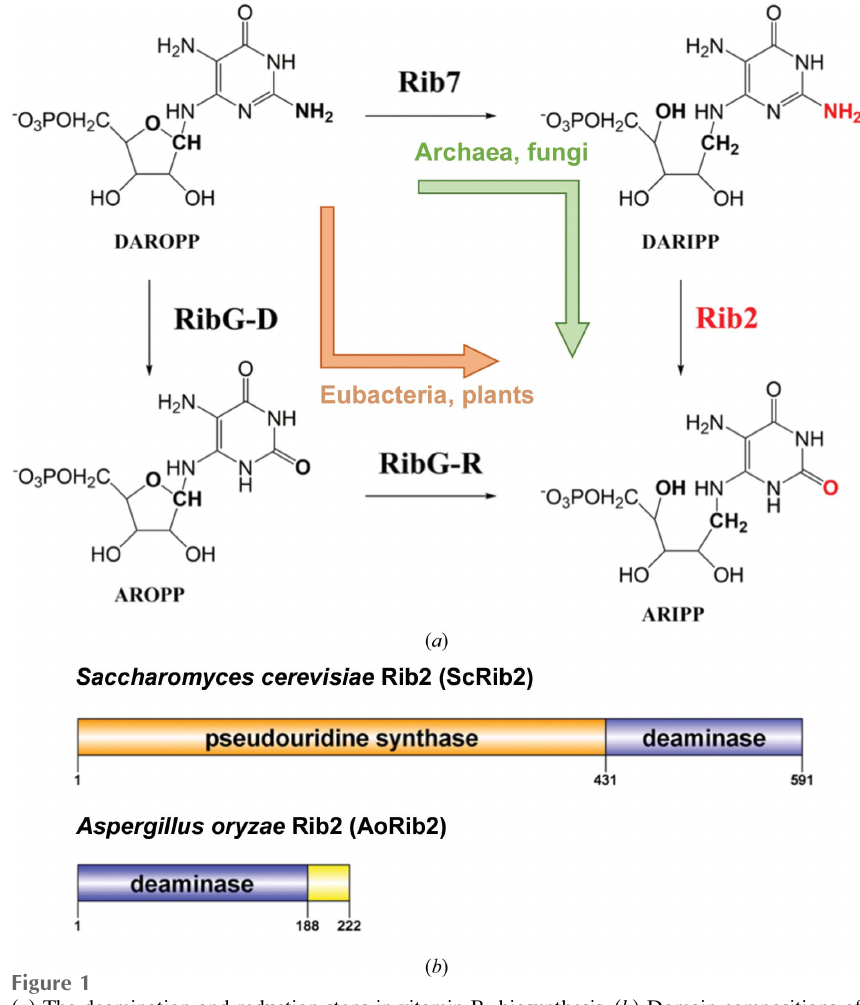
Figure 1 ( a ) The deamination and reduction steps in vitamin B 2 biosynthesis. ( b ) Domain compositions of ScRib2 and AoRib2. The pseudouridine synthase domain is shown in orange and the deaminase domains are shown in blue. A charged residue-rich segment is shown in